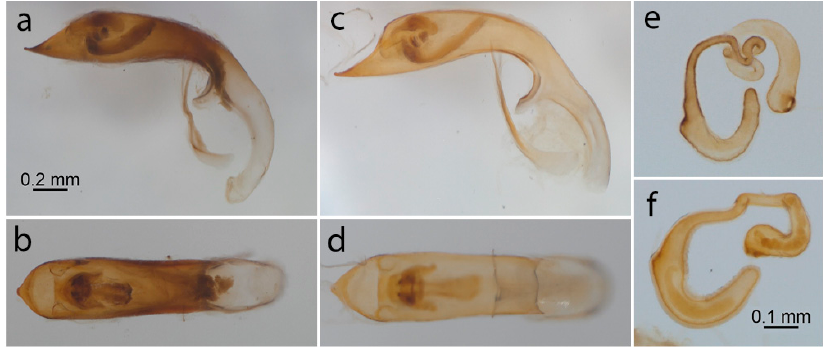
Figure 3. Lema bilineata : aedeagus in lateral ( a ) and dorsal ( b ) view; spermatheca ( e ). Lema daturaphila : aedeagus in lateral ( c ) and dorsal ( d ) view; spermatheca ( f ). Color pattern : relatively constant on the elytra, but the pronotum and the ventral region show